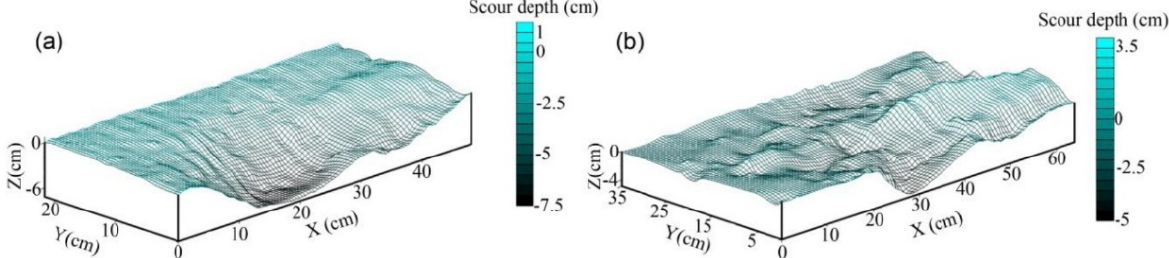
Figure 3. Topography of the final scouring hole around the abutment: ( a ) without vegetation (abutment coordinates: x = [16,31], y = [0,r], z= [0,40]); ( b ) with vegetation (abutment coordinates: x = [28,43], y = [0,r], z = [0,40]).